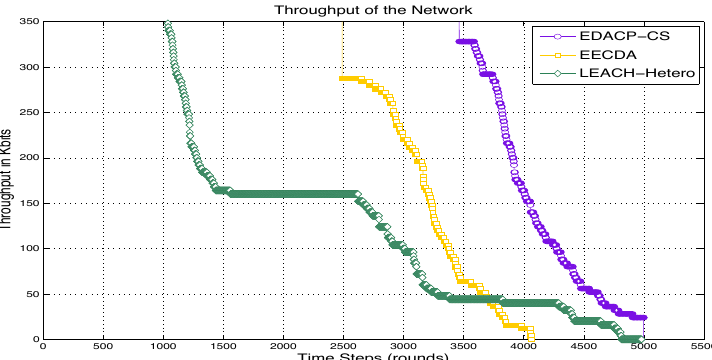
Figure 10. Throughput of the